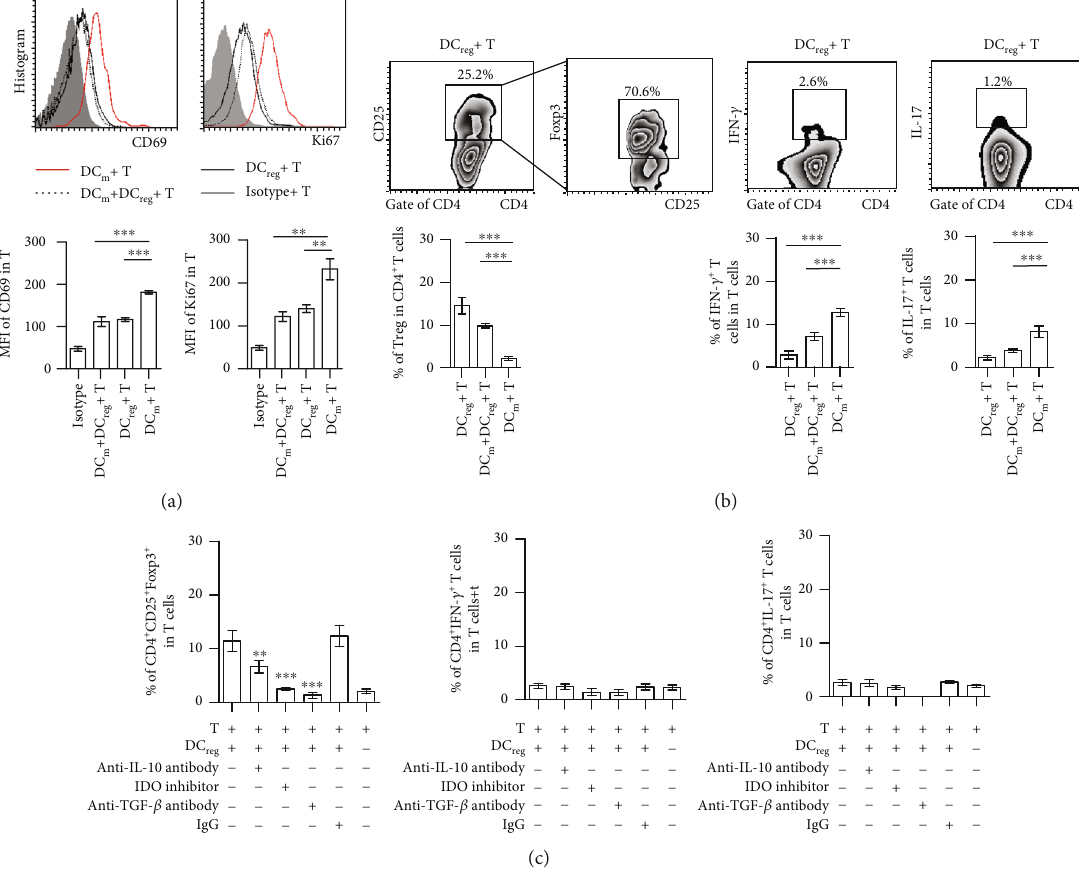
Figure 3: DC in fl uence the activation of T cells and induce CD4 + CD25 + Foxp3 + T cells in vitro . (a) The expression of CD69 and Ki67 on the reg T cells cocultured with DC , DC , and both of them. DC and DC were isolated from the eyes of EAU and cocultured with T cells from reg m reg m EAU ( DC : T = 1 : 10 ) for 24-48 h. (b) The percentage of CD4 + IFN- γ + T cells, CD4 + IL-17 + T cells, or CD4 + CD25 + Foxp3 + T cells in T cells cocultured with DC , DC , and both of them. (c) With blocking IL-10, IDO, and TGF- β alone in the coculturation of T cells and DC reg m not, the percentage of CD4 + CD25 + Foxp3 + T cells, CD4 + IFN- γ + T cells, or CD4 + IL-17 + T cells compared with those without treatment (experiments were replicated three times, data were presented as mean ± standarderror of the mean (SEM), ANOVA test, and ∗ P < 0 : 05 , ∗∗ P < 0 : 01 , and ∗∗∗ P < 0 : 001